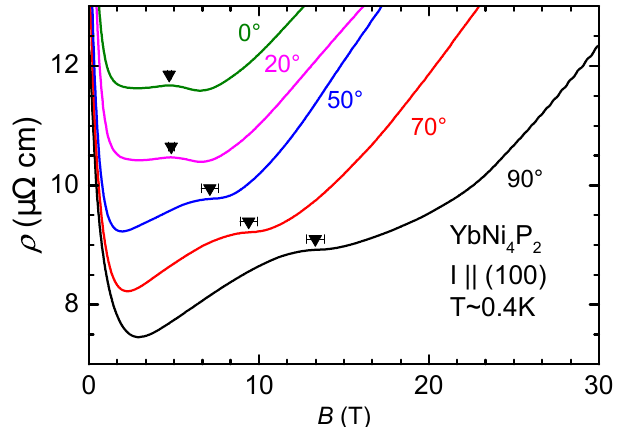
Figure 4: (a) in-plane magnetoresistance ρ for representative orientations. Labels xx indicate the polar angle φ between the magnetic field and the crystallographic (001) direction. Arrows indicate the position of representative Lifshitz transitions. Data are offset for